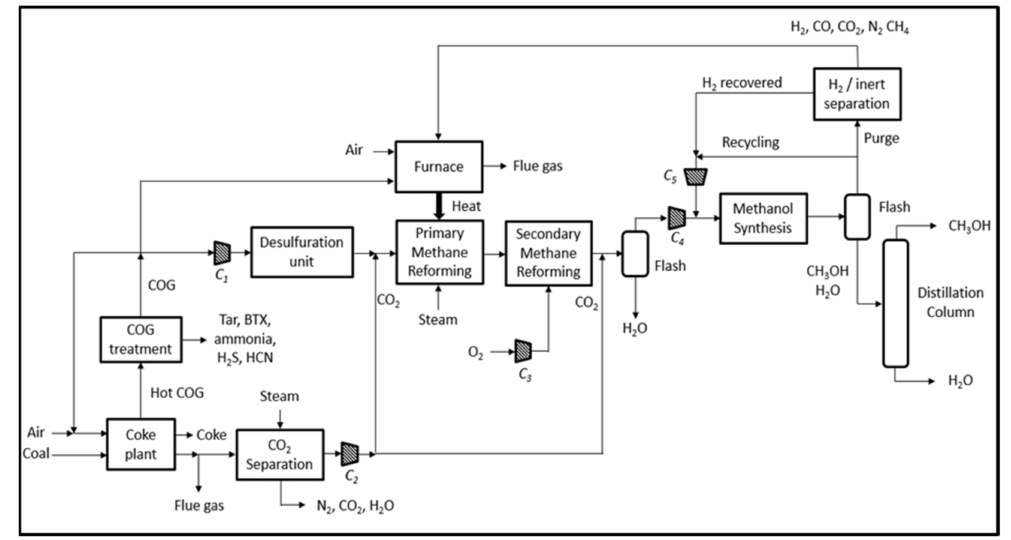
Figure 2. Simplified process flowsheet for the case study A1 (combined reforming of COG).